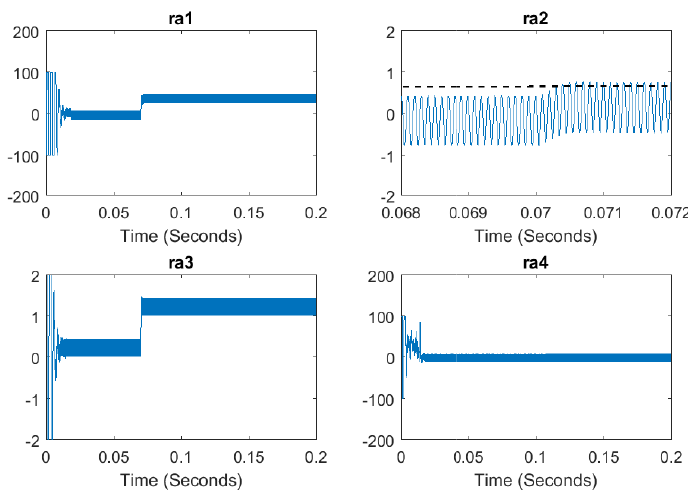
Figure 17. Simulation of residuals in the case of the sensor Df 2 fault.